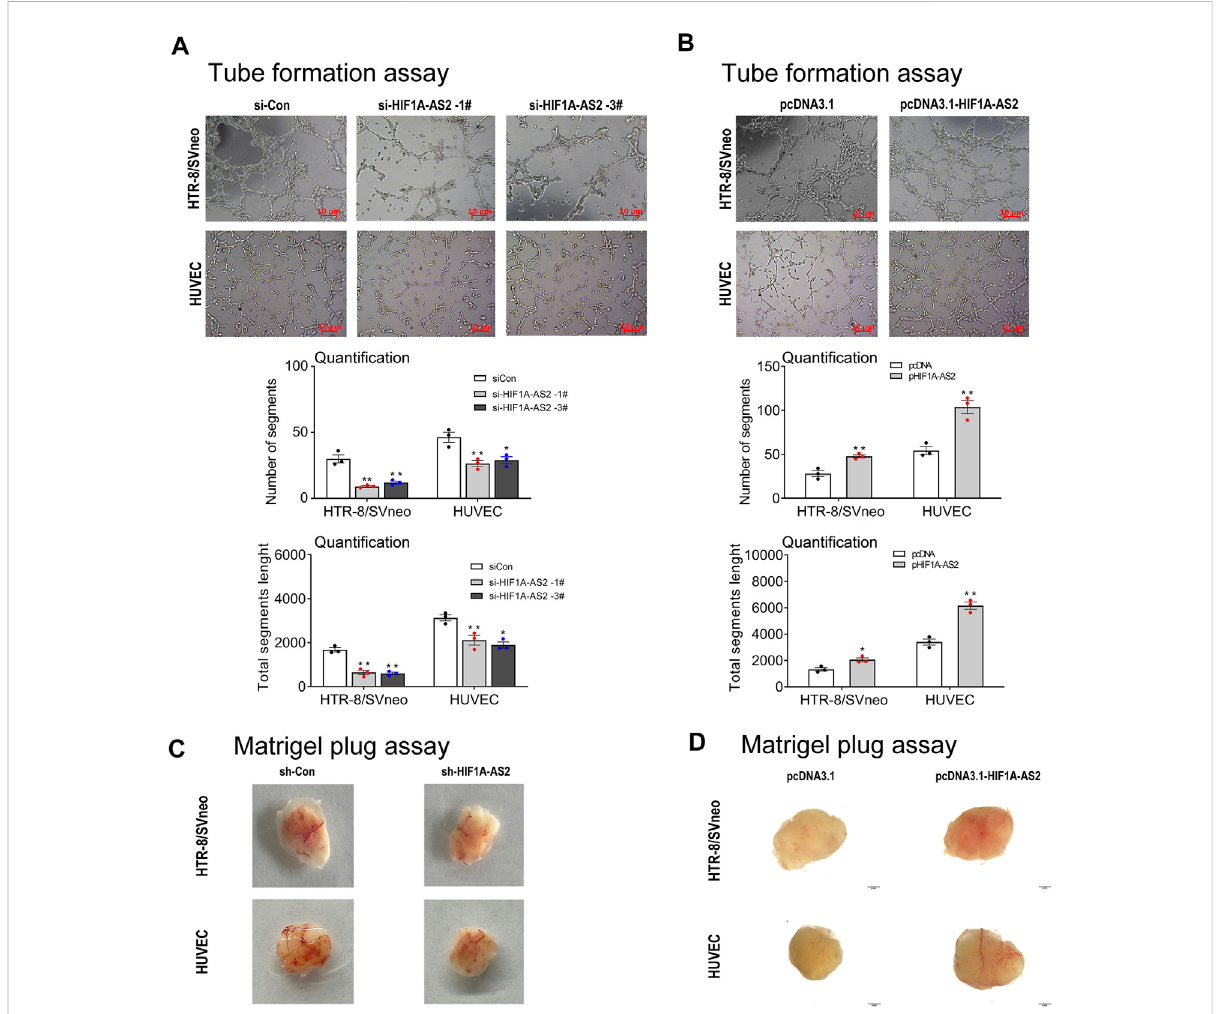
FIGURE 3 HIF1A-AS2 affects angiogenesis of HTR-8/SVneo trophoblast and HUVEC cells in vitro and in vivo . Consequent to network formation, the number of segments and total segments length of the network were decreased in HIF1A-AS2 with siRNAs (A) and increased in overexpressed with pcDNA3.1- HIF1A-AS2 (B) in HTR-8/SVneo and HUVECs, respectively. The quantity of cells is shown below the corresponding graph. The Matrigel plug assay showed that HIF1A-AS2 -related siRNA inhibited angiogenesis in nude mice (C) , and overexpression of HIF1A-AS2 promoted angiogenesis (D) . Error bars are mean with SEM of technical replicates ( n = 3). * p < 0.05, ** p < 0.01; signi fi cance by Student ’ s t